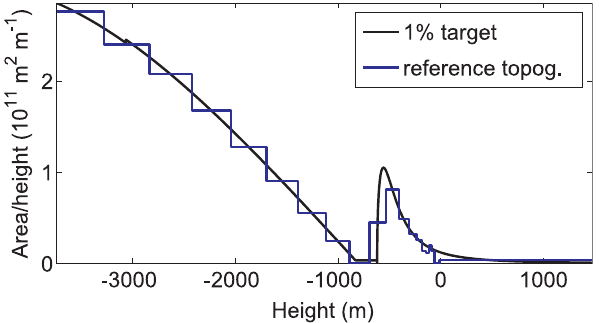
Fig. 5. Area-per-depth distribution used in the simulations of the early Archean. The black line represents the physically motivated distribution, and the blue line shows the actual distribution underly- ing the discrete model topography field.